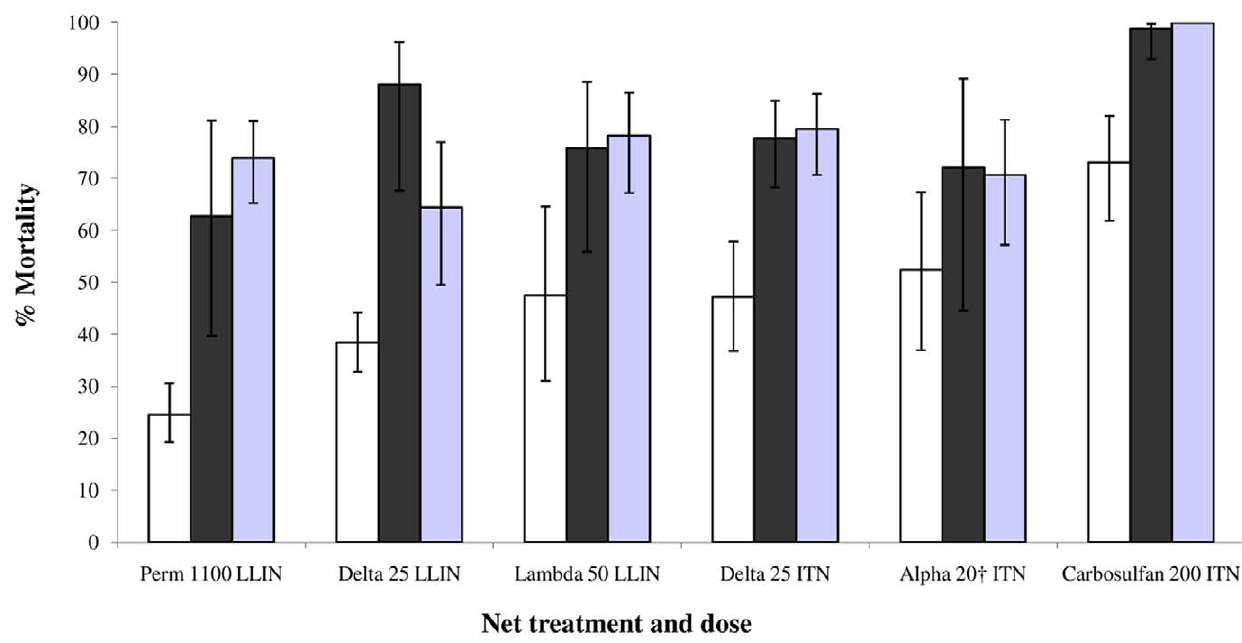
Figure 2. Overall mortality of free flying mosquitoes ± 95% confidence interval. Anopheles arabiensis (white), An. gambiae (black) and An. funestus (grey) species.